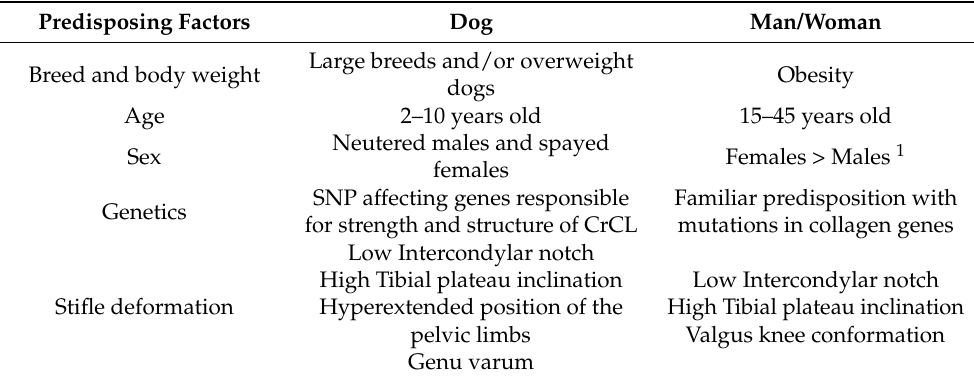
Table 1. Main predisposing factors for Cranial cruciate ligament (CrCL) rupture in dogs in compari- son with humans. Predisposing Factors Dog Man/Woman Large breeds and/or overweight Breed and body weight Obesity dogs Age 2–10 years old 15–45 years